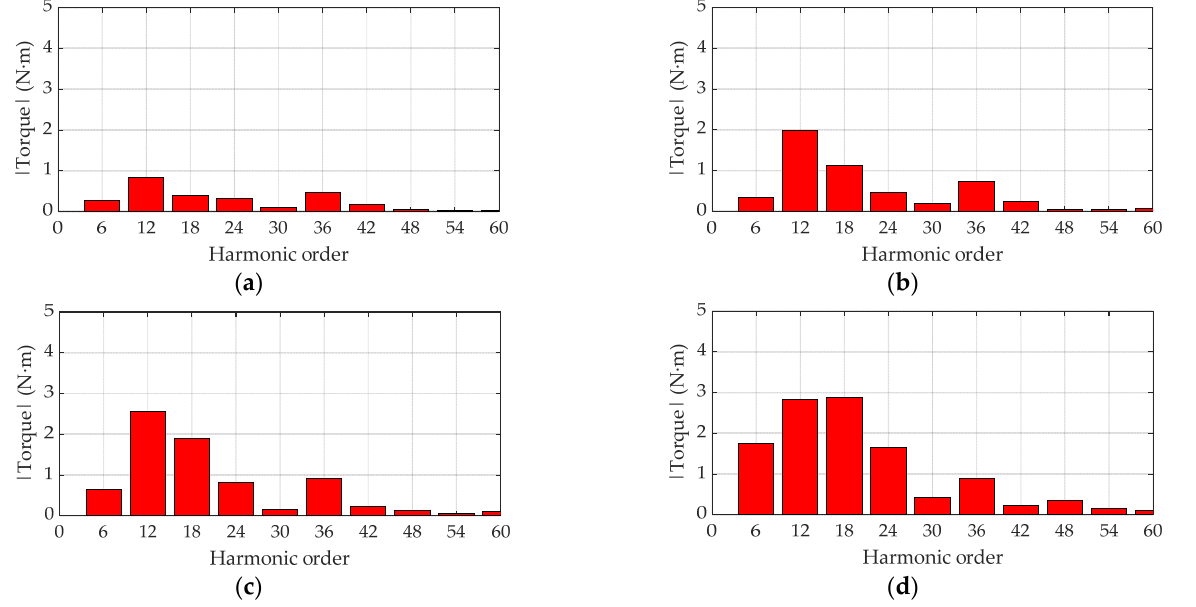
Figure 9. Designs obtained from the optimization process. The current was fixed to ~20 A/mm 2 and the current angle was defined in the optimization algorithm for MTPA.